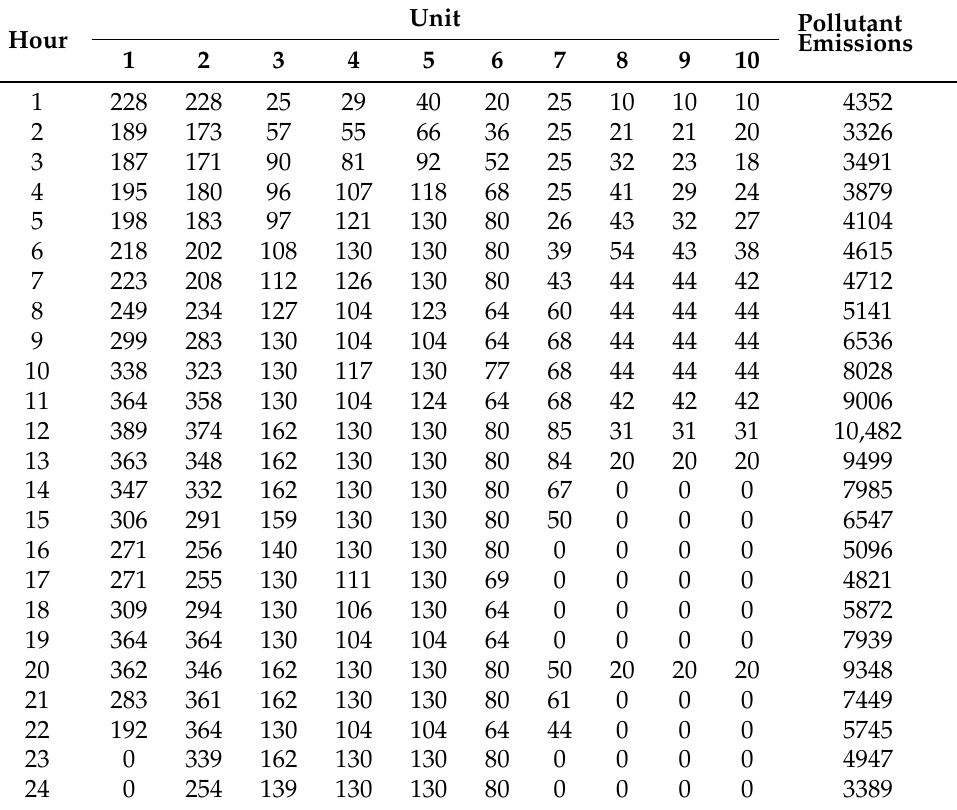
Table 5. The output and pollutant emission for the 10 thermal